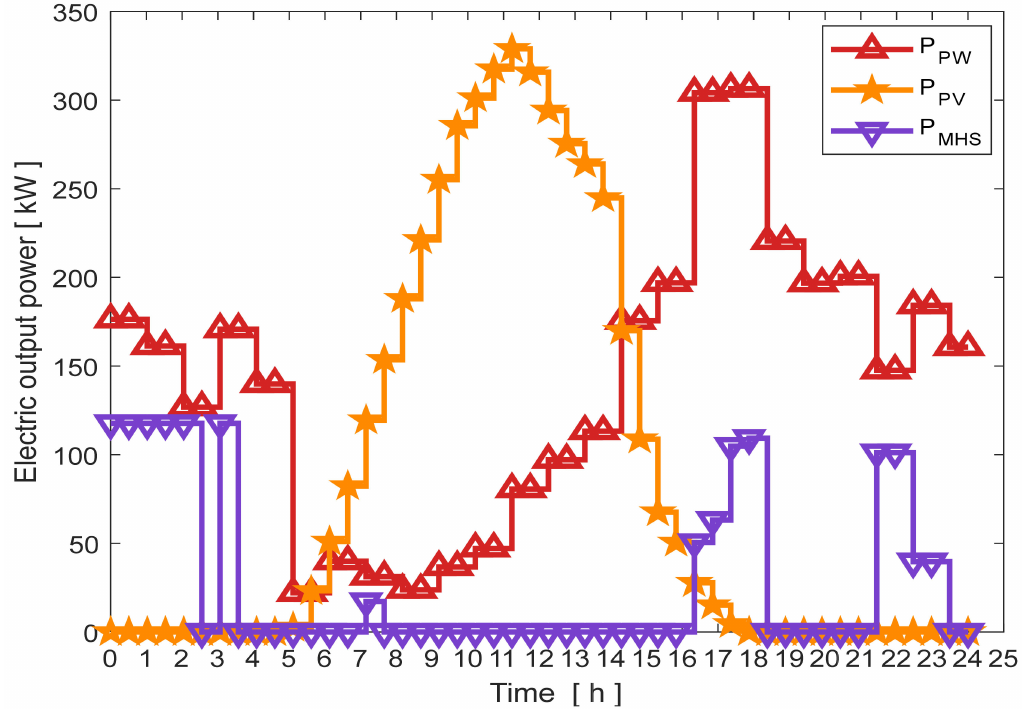
Figure 10. Power production of renewable-based multi-energy